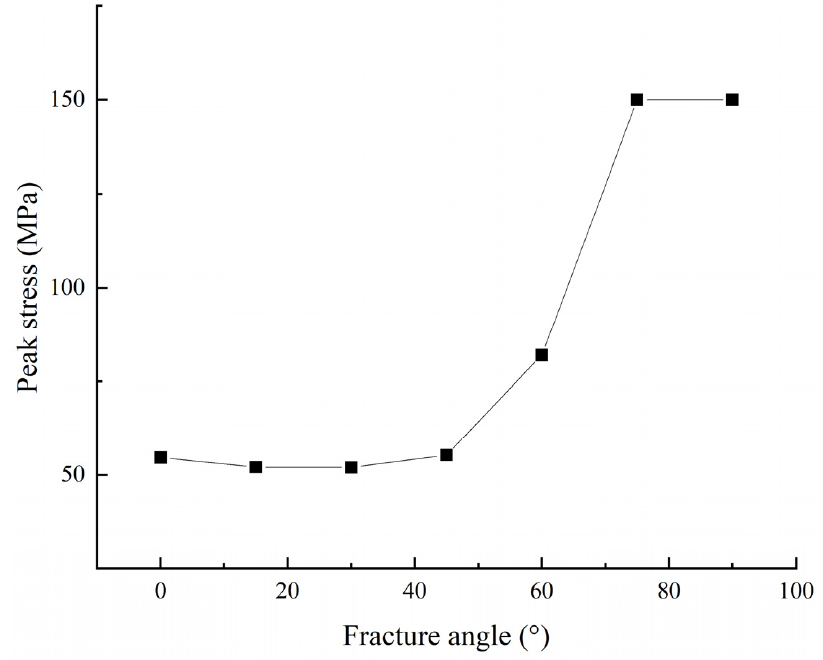
Figure 10. When the fracture angle is between 45° and 75°, the peak stress changes greatly.